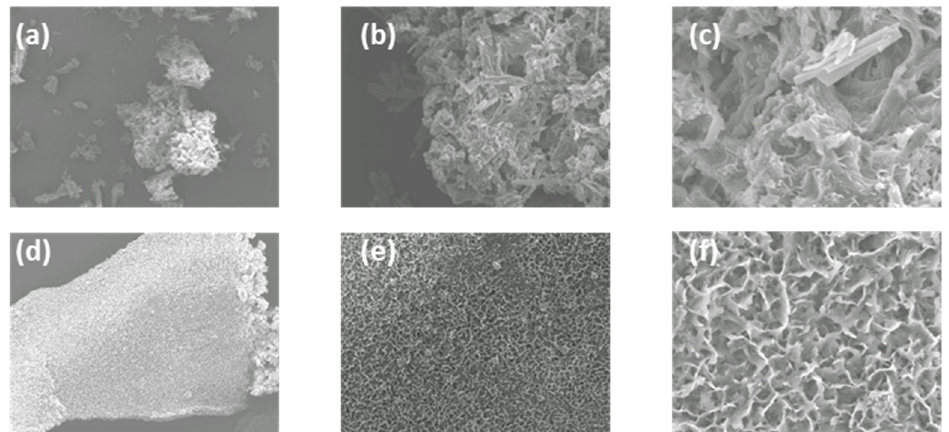
Figure 3. Scanning electron microscopy (SEM) images of the aggregates formed by self-assembly of ( a – c ) SN1 and ( d – f ) SN2 .